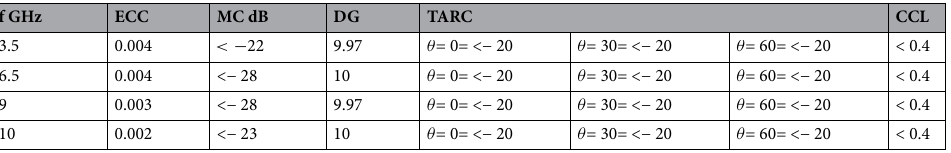
Table 3. MIMO diversity analysis of 2-element UWB MIMO antenna: (Mutual Coupling (MC), Envelope Correlation Coefficient (ECC), Total Active Reflection Coefficient (TARC), and Channel Capacity Loss (CCL) are measured).